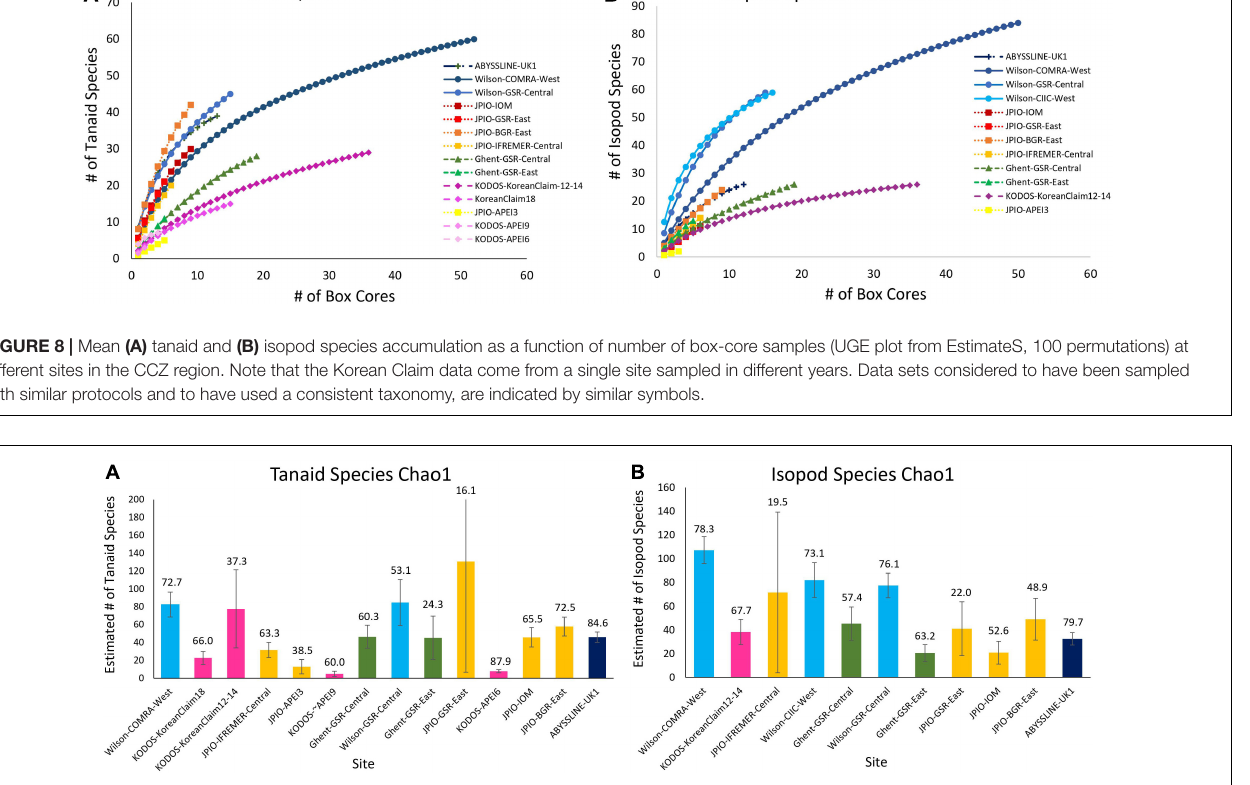
FIGURE 9 | Chao 1 (+SD) estimate of species richness for (A) tanaid and (B) isopod assemblages at the various sites sampled across the CCZ. Numbers over bars indicate the percentage of estimated species richness that has been collected at each